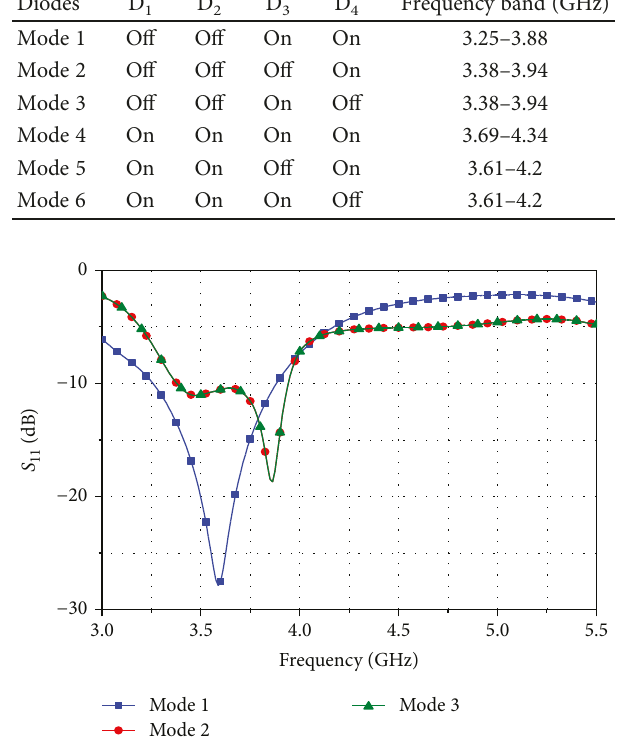
Figure 2: Simulated input re fl ection coe ffi cients in modes 1, 2, and 3.